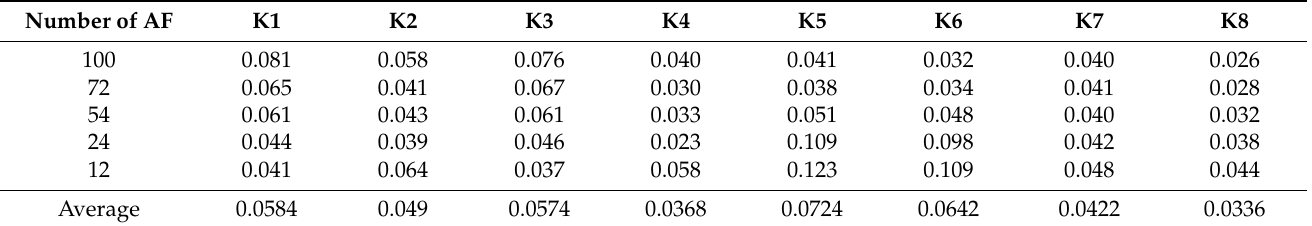
Table 8. Average tracking time of random deployment in target tracking.